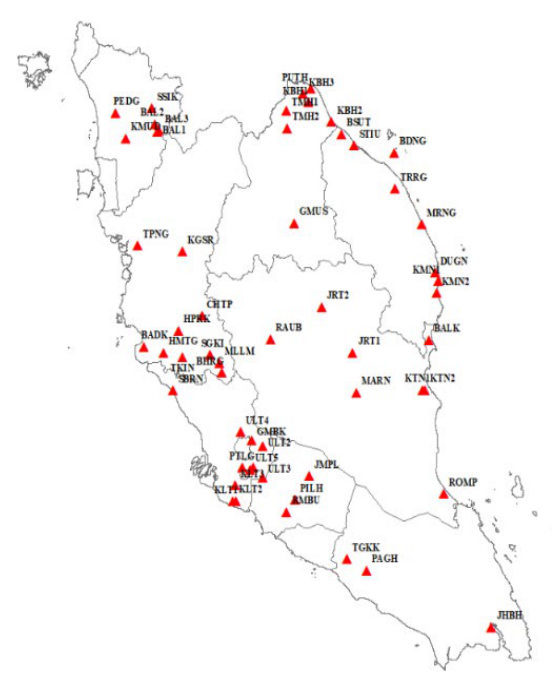
Figure 4. Distribution of JMG tube well in Peninsular Malaysia Figure 3. Monsoon seasons in Malaysia Figure 5 shows the time series graph of groundwater storage anomaly for the tube well, highlighting the patter of water level. Red lines represent the original data and the green lines represent smoothed data using moving average method. The blue solid line represents the robust fit simulation, while the black dashed line represents robust fit regression. The groundwater rates for